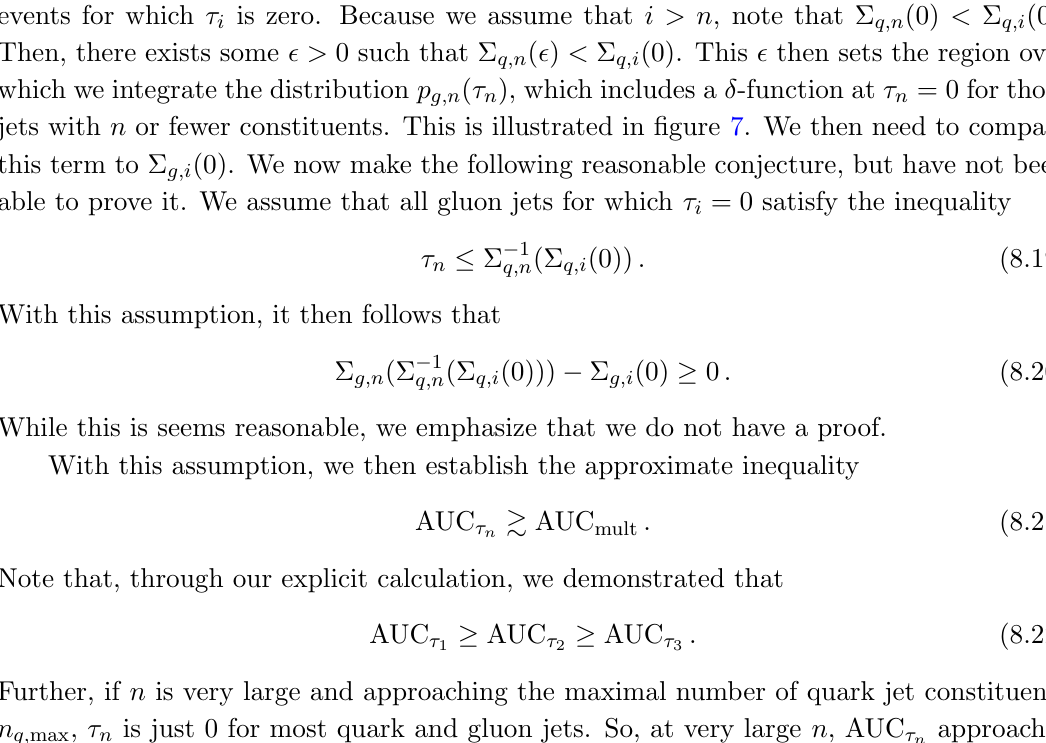
Figure 7. Illustration of the integration region over N -subjettiness (cid:28) distribution that de(cid:12)nes the quantity (cid:6) g;n ((cid:6) (cid:0) 1 those jets with n or fewer